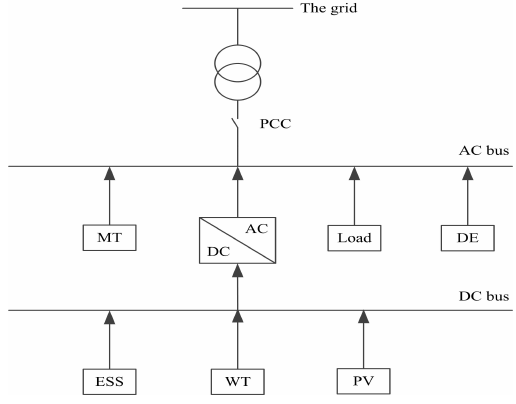
Figure 1. The structure of a